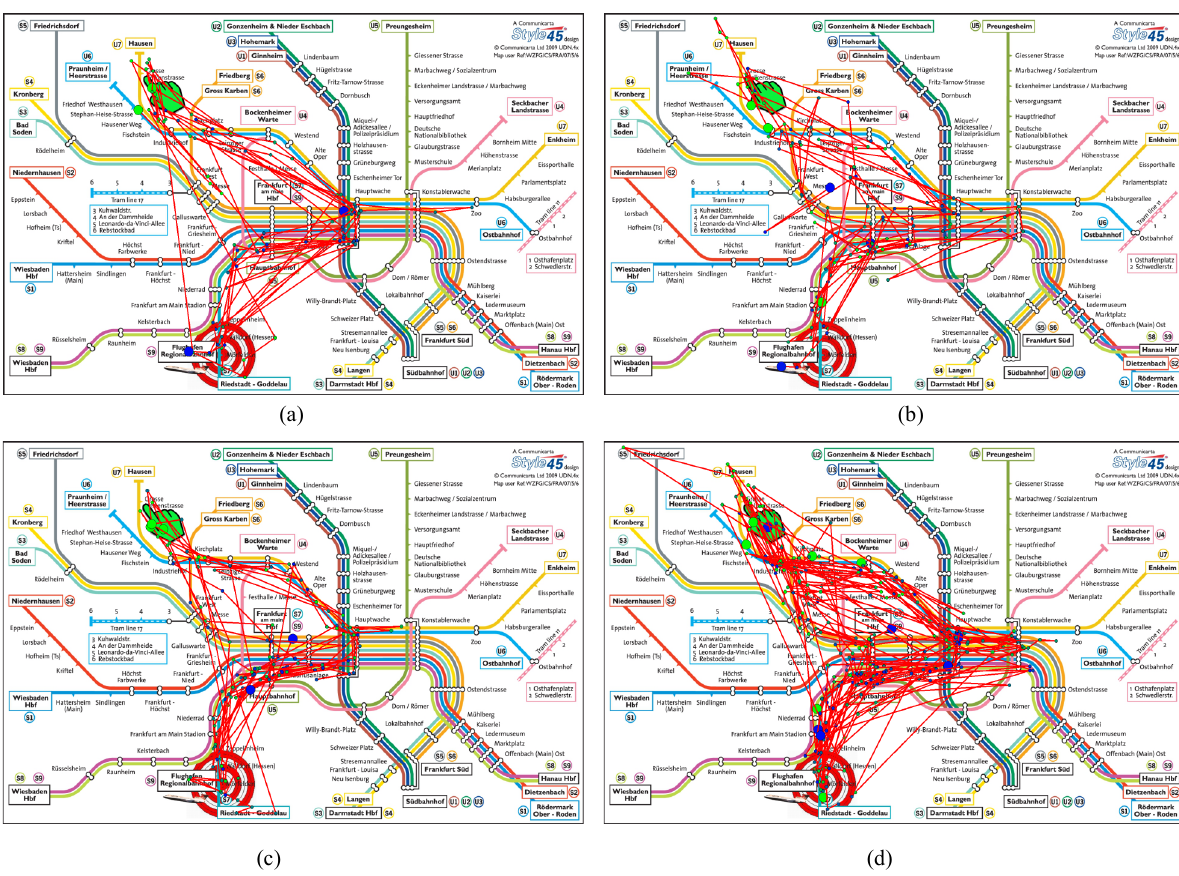
Figure 15 . Examples of scanpaths for participants that were confronted with color-encoded metro maps. (a) shows scanpaths of participants who are contained in group (b), selected from the horizontal axis. (b) shows scanpaths of participants who are con- tained in group (a), selected from the horizontal axis. (c) and (d) show scanpaths of participants selected from the vertical axis who are included in group (a) and (b). Scanpaths in (c) are more similar to (a), since they are focused on a path leading from the start to the main station and then to the destination. Scanpaths in (d) are more similar to those in (b), since they are less focused on one specific path involving also areas left and right of the main station. The start location is designated with a green hand and the desti- nation with a target symbol. The start of the scanpath is indicated by a big green dot and the end of the scanpath by a blue dot. The color of smaller fixations in between is gradually changing from green to blue encoding the temporal ordering of the